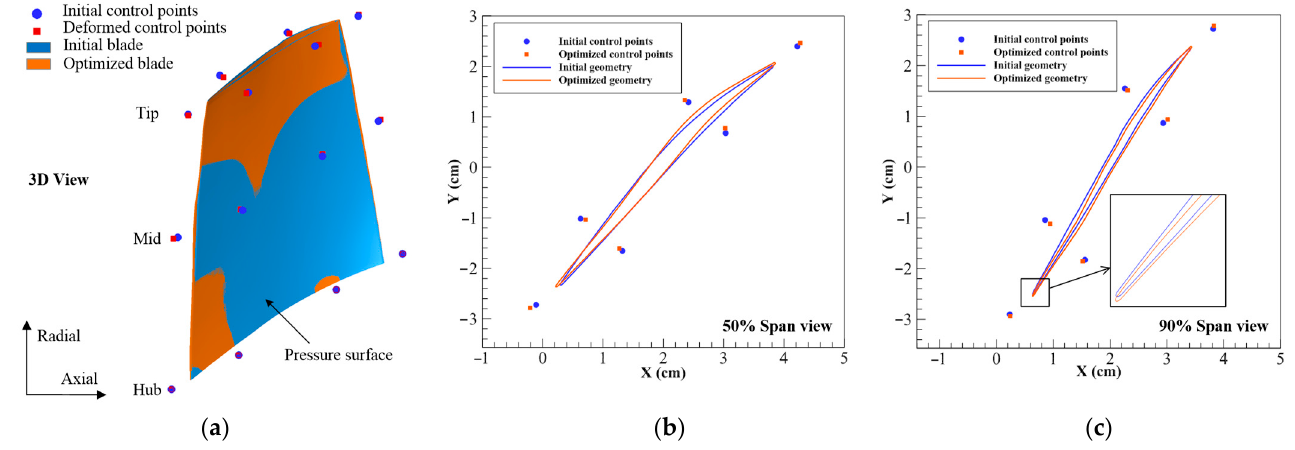
Figure 10. The comparison of the optimized and initial blade. ( a ) The 3-D diagram of the comparison of the deformed and initial blade; ( b ) the 50% span view of the deformed and initial blade; and ( c ) the 90% span view of the deformed and initial blade.